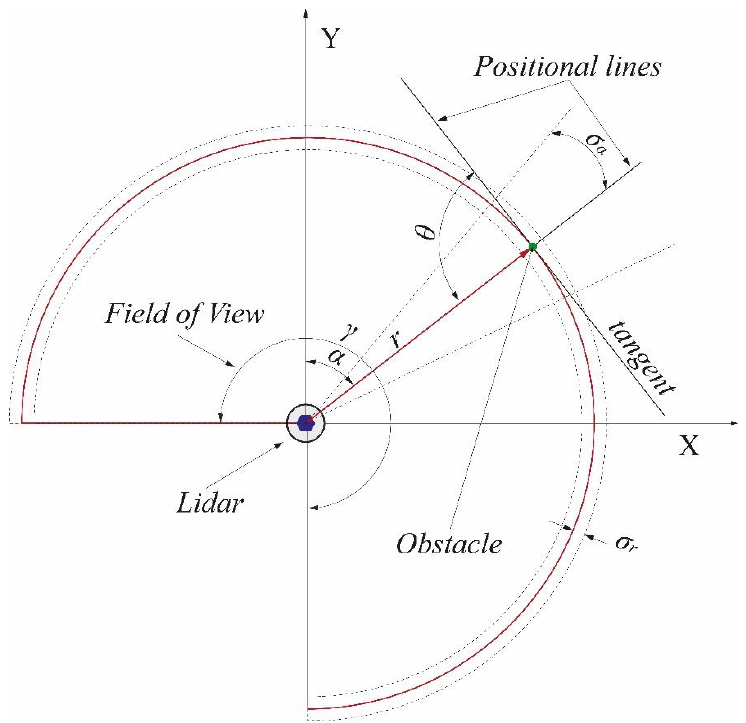
Figure 1. The principle of measuring 2D horizontal coordinates ( x , y ) using Light Detection and Ranging (LIDAR)